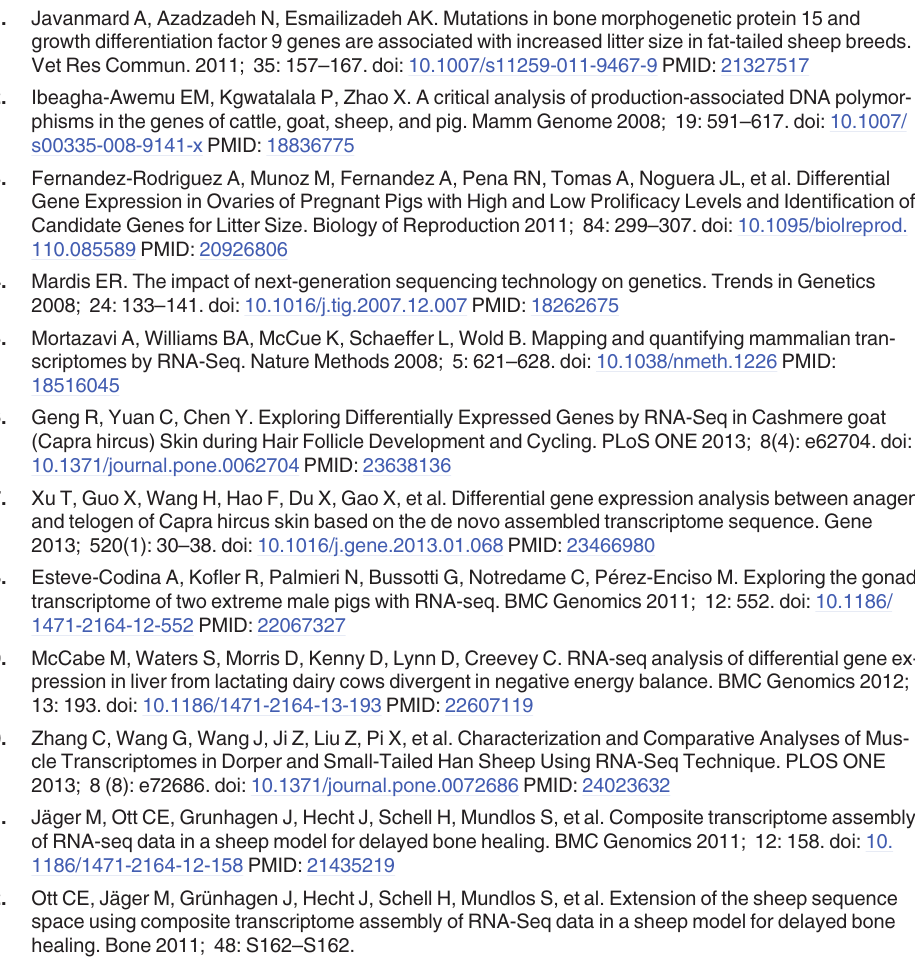
S1 Table. Expression statistics for reference genes in the Qira black sheep and Hetian sheep. S2 Table. Differential expression genes between Hetian sheep and Qira black sheep. S3 Table. Significantly enriched pathway of differential expressed